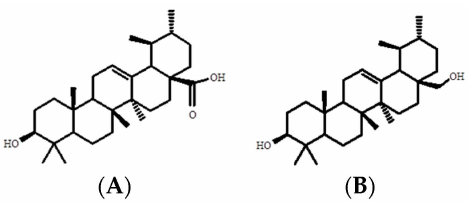
Figure 2. Chemical structures of ursolic acid ( A ) and uvaol ( B ). Table 1. Spectroscopic constants of ursolic acid.